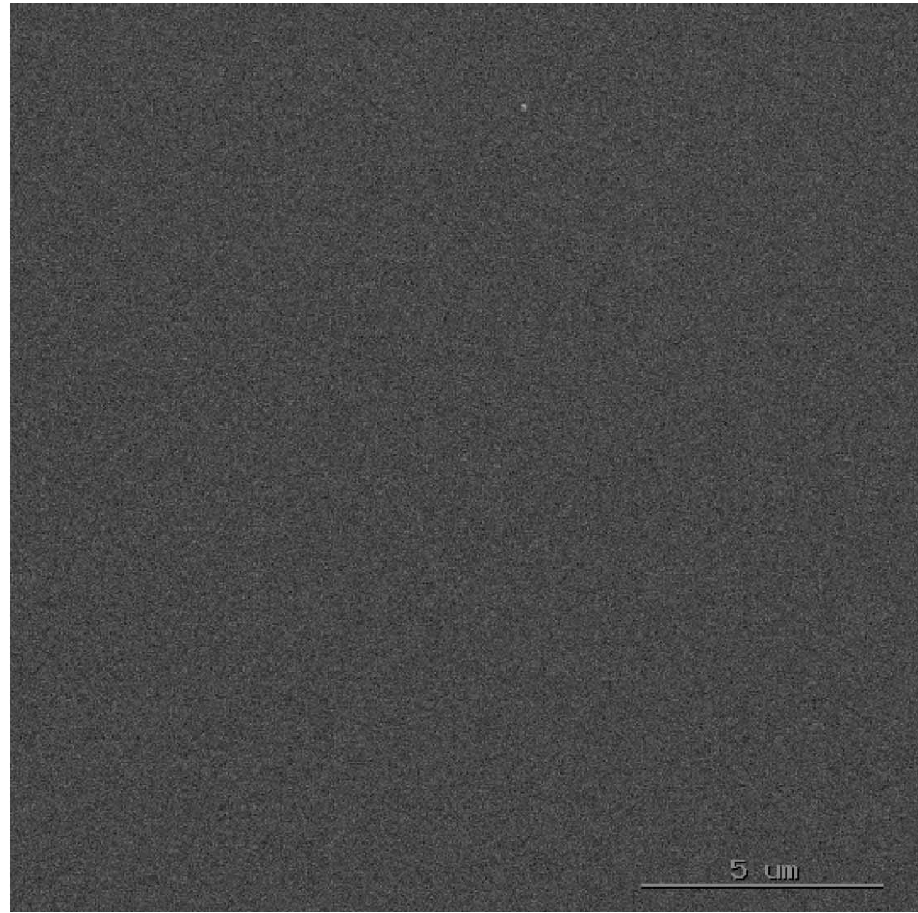
FIGURE 10 SEM for quenched sample of n -Si from 700 (cid:1) C with scale of 5 m